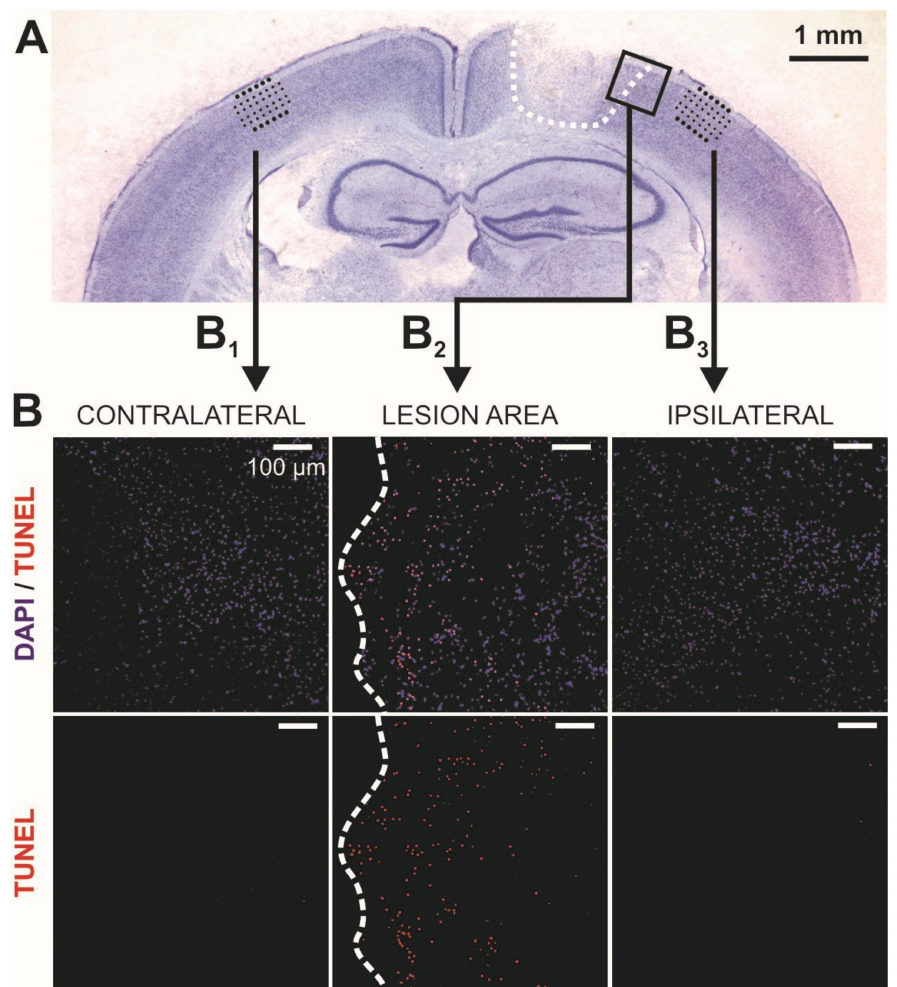
Figure 1. Histology of the controlled cortical impact (CCI) lesion. ( A ) Representative example of a Nissl stained coronal section of the sensorimotor cortex from a 20-day-old mouse at 1 day post-CCI. The black dotted squares represent the perforated microelectrode array (pMEA) chip position for monitoring extracellular signals, the recording electrodes were located in supra-granular layers 2 / 3. We recorded 1 mm lateral from the border of the lesion and in the homotopic region of the contralateral hemisphere and sham animals. ( B ) Some slices were treated with an in situ TUNEL assay to detect early signs of apoptosis. The resulting confocal images were taken in specific areas of the cortical slice as shown in Figure 1A (see arrows) and are shown at a higher magnification (the white scale bar corresponds to 100 µ m). B1 shows an example of a confocal image of the homotopic area of the contralateral hemisphere, images in B2 were taken from the lesion area in the ipsilateral hemisphere, while images in B2 were derived at 1 mm distance from the border of the lesion in the ipsilateral hemisphere. Note that TUNEL positive cells were detected at the close border of the lesion (white dashed line). In contrast, at more distant areas ipsilateral (1 mm distance to the lesion) and contralateral, the MEA-recording sites revealed almost no signs of